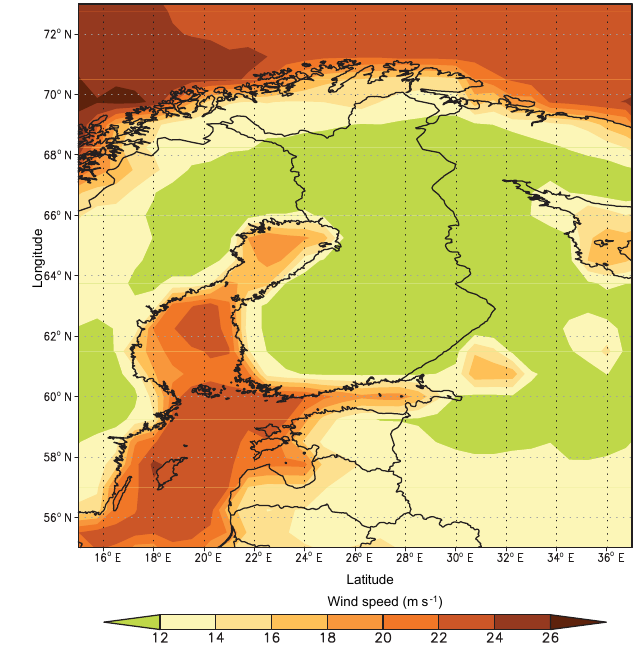
Figure 1. Ten-year return level of maximum wind speed calcu- lated using ERA-Interim 1979–2015 data and the GEV analysis ap-